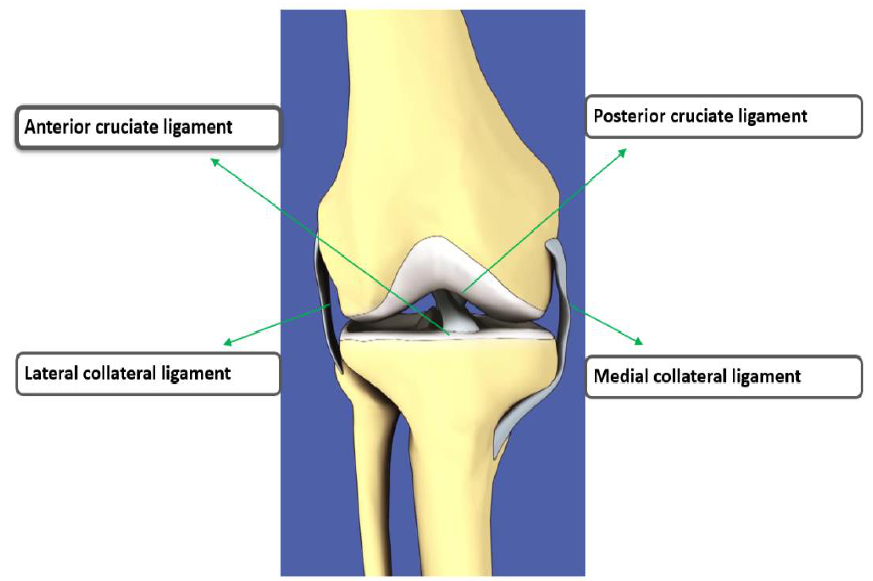
Figure 1. The front view of the 4 major ligaments of knee anatomy, where the anterior cruciate ligament (ACL) is located at the center of the knee, the posterior cruciate ligament at back of the knee, the medial collateral ligament at the inner knee and the lateral collateral ligament at the outer knee [2].